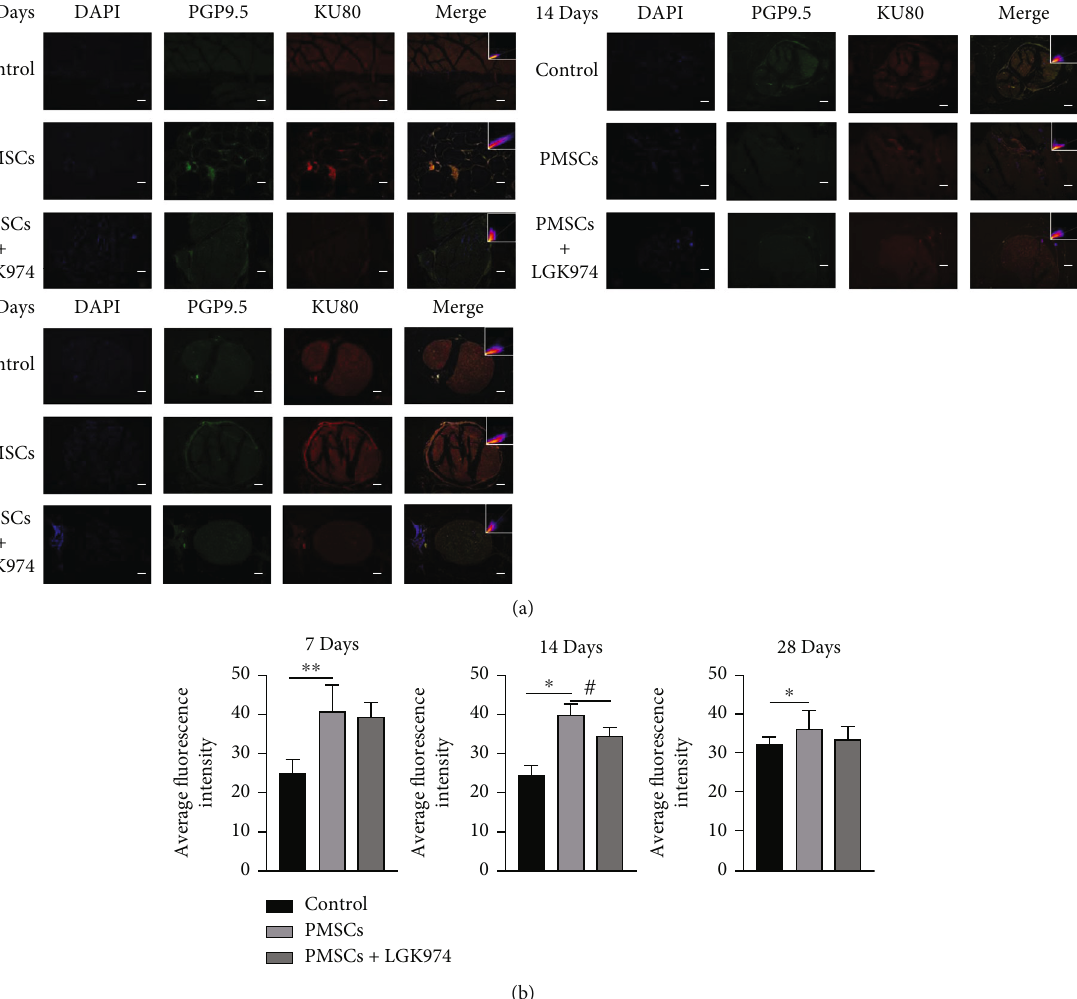
Figure 5: Immuno fl uorescence imaging of PGP9.5 and Ku80 in the sciatic nerve. (a) PGP9.5 was highly expressed in the PMSC group but lower in the control group at 7, 14, and 28 days. Contrarily, the upregulation of PGP9.5 by PMSCs was signi fi cantly inhibited by LGK974, and there was statistically signi fi cant di ff erence at 14 days. The results demonstrated that KU80 was expressed in sciatic nerve. (b) Quantitative measurements were expressed as mean fl uorescence intensity. Data were mean ± SEM . n = 3 ; ∗ PMSC group vs. control group, P < 0.05; # PMSC group vs. PMSC+LGK974 group, P < 0 : 05 . The scale bar: 50 μ